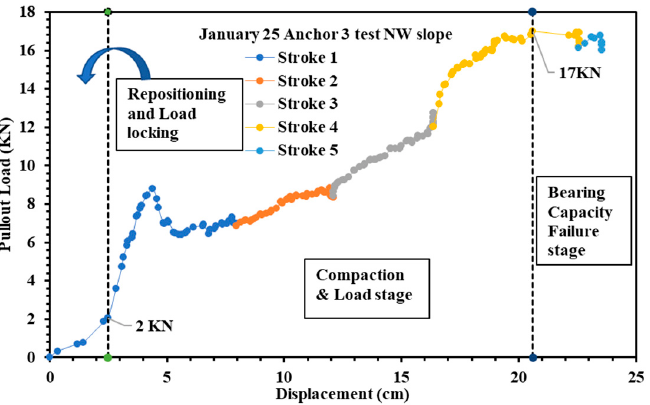
Figure 13. Anchor 3 pull-out test, combined strokes, northwest bank, 25 January 2022.